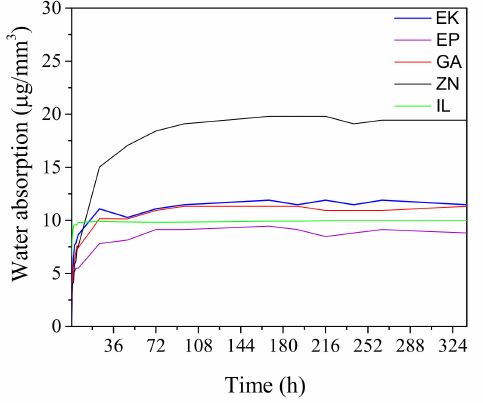
Figure 5. Water absorption behavior of the as-received clear aligners measured at different immersion times at a temperature of 37 ◦